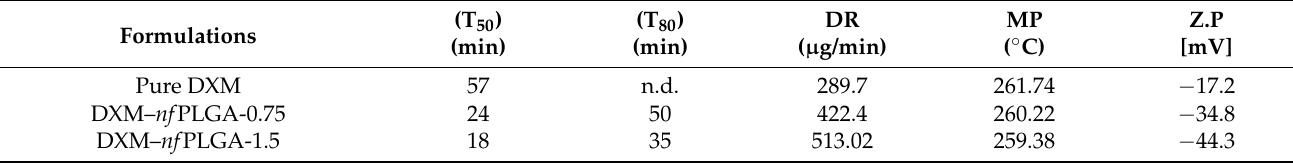
Figure 8. ( a ) DXM– nf PLGA composites TGA analysis and ( b ) % nf PLGA incorporation.